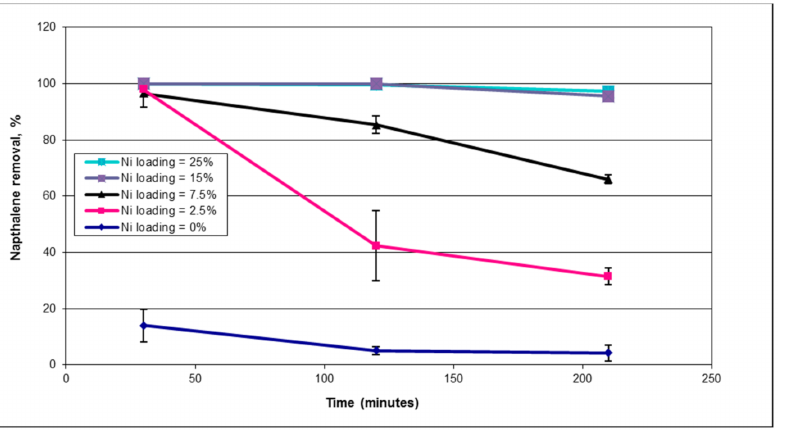
Figure 7. Effect of nickel loading on naphthalene removal efficiency (T—750 ◦ C, S/C—5, GHSV— 12,800 h − 1 , naphthalene loading—58 g/Nm 3